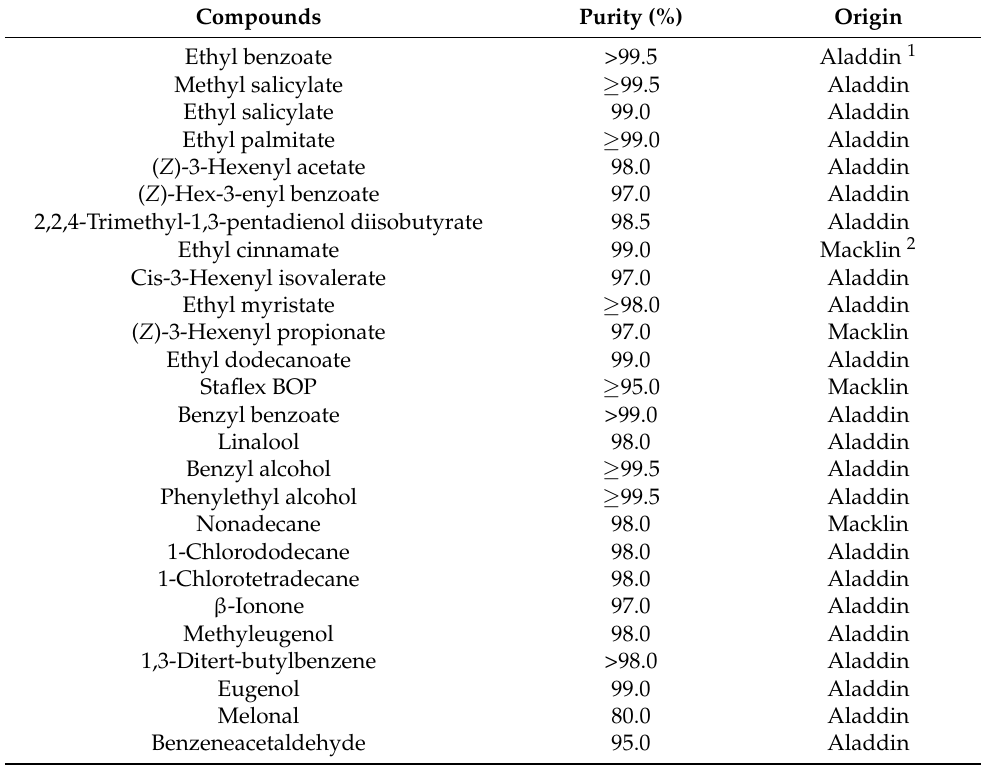
Table 1. Information of standard compounds used in the EAG tests and the Y-tube experiments to A. mellifera and B. terrestris